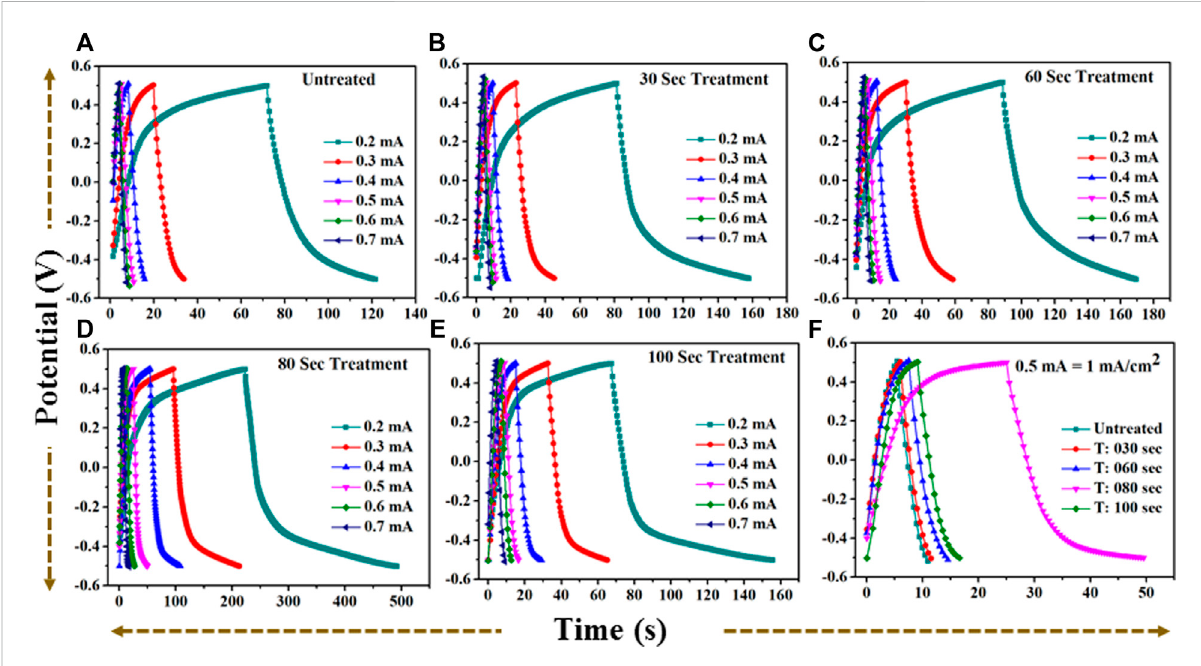
FIGURE 9 (A) : GCD pro fi le for untreated TiO2 at current (0.2 – 0.7) mA. (B) : GCD pro fi le for 30 s plasma treated TiO2 at current (0.2 – 0.7) mA. (C) : GCD pro fi le for 60 s plasma treated TiO2 at current (0.2 – 0.7) mA. (D) : GCD pro fi le for 80 s plasma treated TiO2 at current (0.2 – 0.7) mA. (E) : GCD pro fi le for 100 s plasma treated TiO2 at current (0.2 – 0.7) mA. (F) : A comparative GCD pro fi le for (A – E) at current 0.5 mA = 1 mA/cm2 current